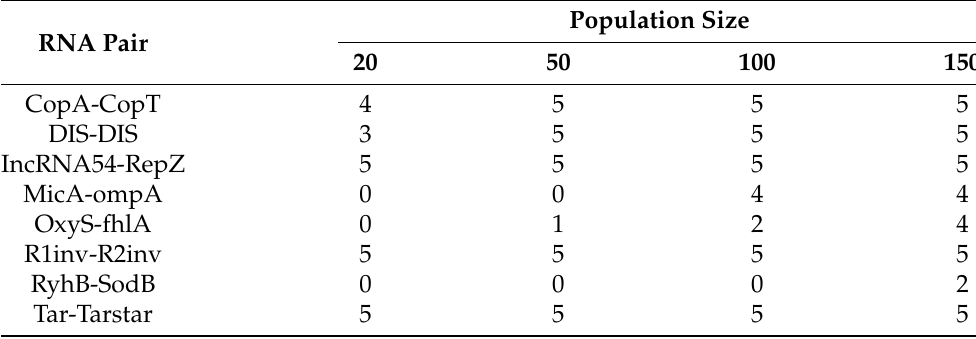
Table 2. The number of “perfect design runs” in the five independent runs (with different initial random numbers) of “MODENA+RactIP (predicted